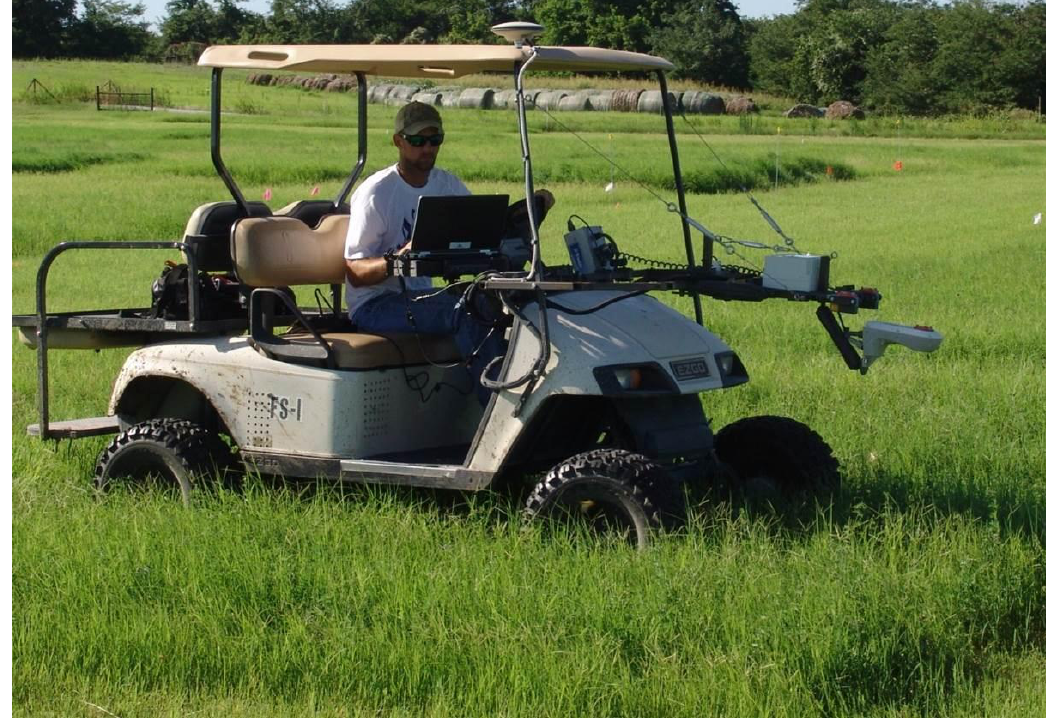
Figure 2. Electric golf cart used for transport of sensors across alfalfa-bermudagrass